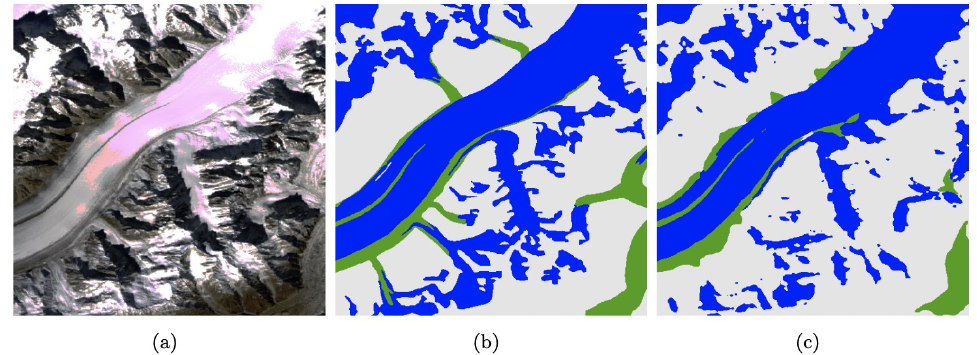
Figure 6. ( a ) Raw image patch. ( b ) Mask patch. ( c ) Predicted patch. The model can detect the position of the bulk of target glaciers but fails to detect connections between